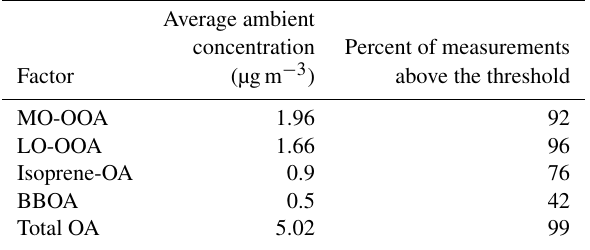
Table 1. Average ambient concentration of each factor and total OA, and the corresponding fraction of the data above the threshold (0.2µgm − 3